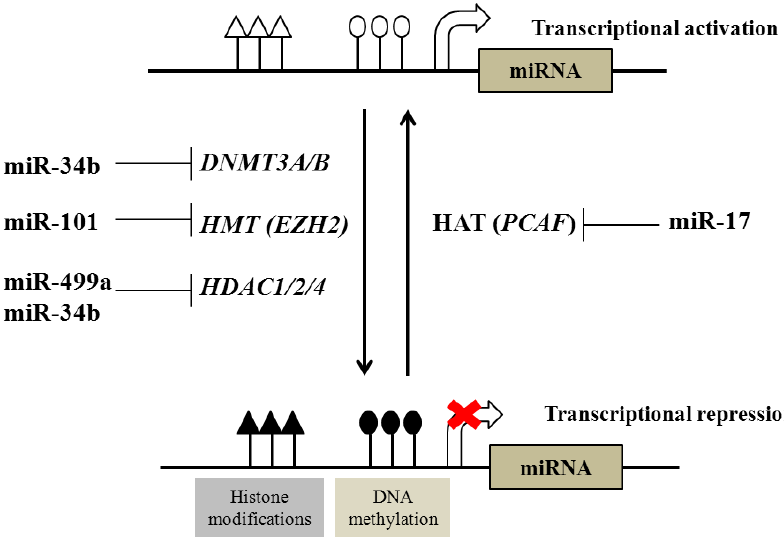
Figure 1. Interactions of DNA/histone modification and miRNA. Epigenetic regulatory mechanisms such as DNA methylation (controlled by DNMTs) and histone modifications modulate epigenetic states and transcriptional responsiveness of both mRNA and miRNA target genes. These actions are controlled by antagonistic classes of enzymes, for example by histone deacetylases (HDACs) and histone acetyl transfereases (HATs). There is good evidence for control of their expression by miRNA. For example, miR-101 targets include EZH2 [71] and miR-499a targets include HDAC1 [72], whereas the